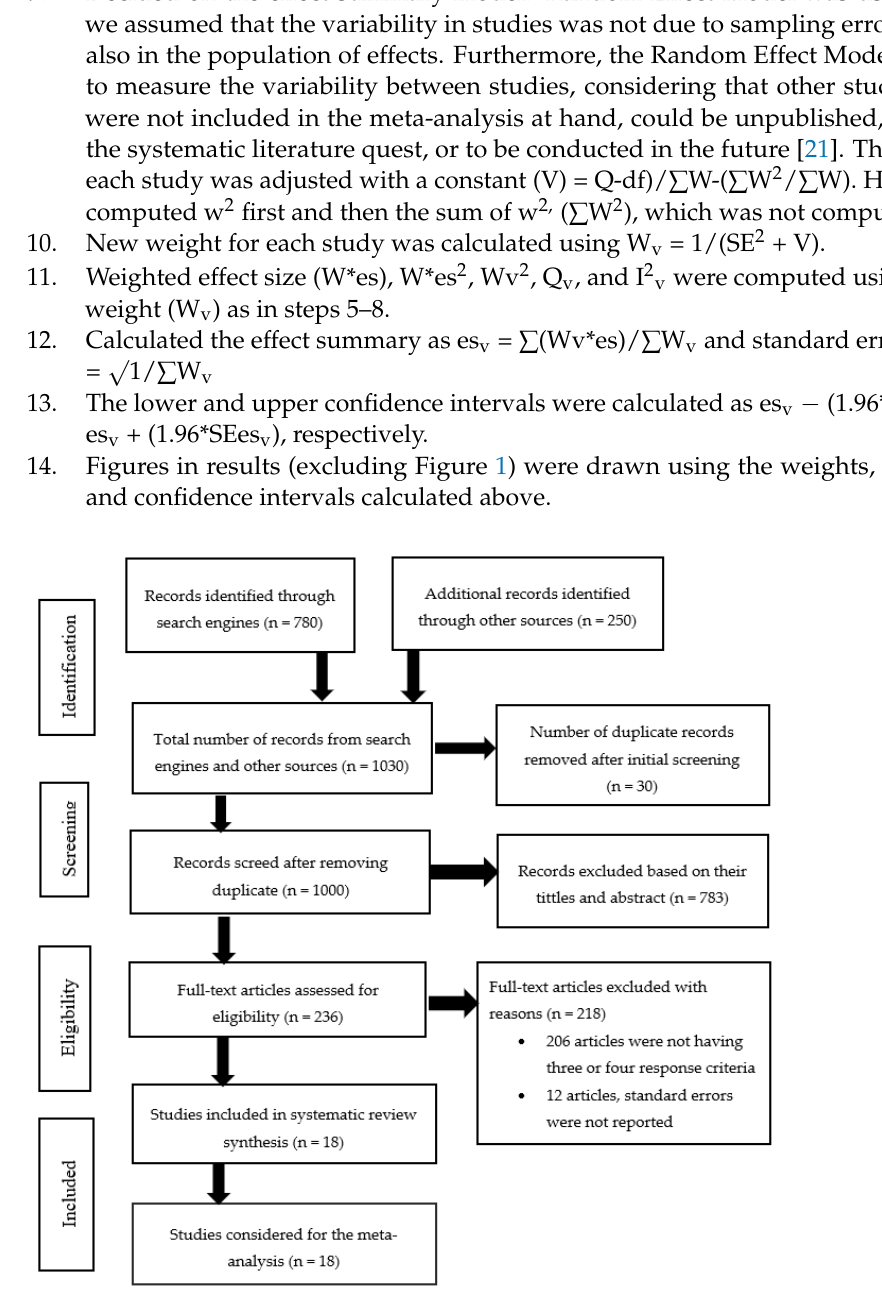
Figure 1. Flow chart of the study selection process for systematic review and meta-analysis of animal protein sources as a fishmeal replacement in aquaculture diets.